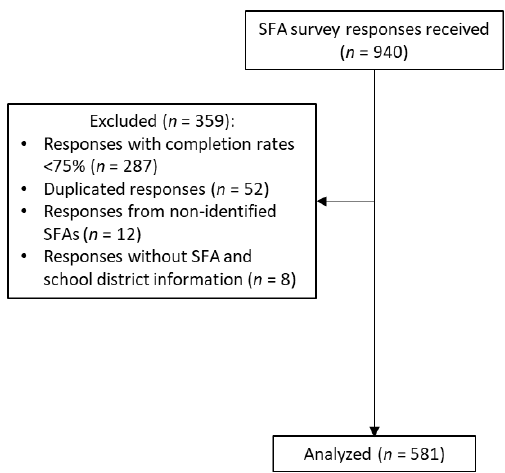
Figure 1. Sample size for the 2022 Californian school food authority survey.